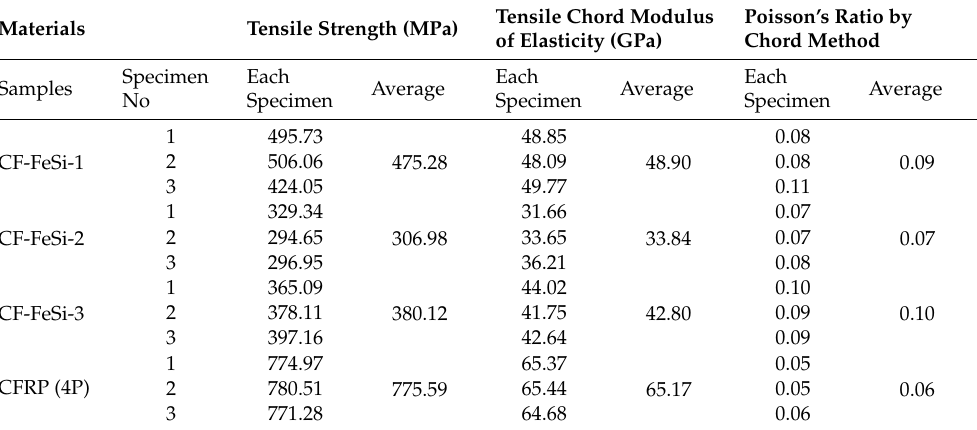
Table 8. Tensile toughness of the